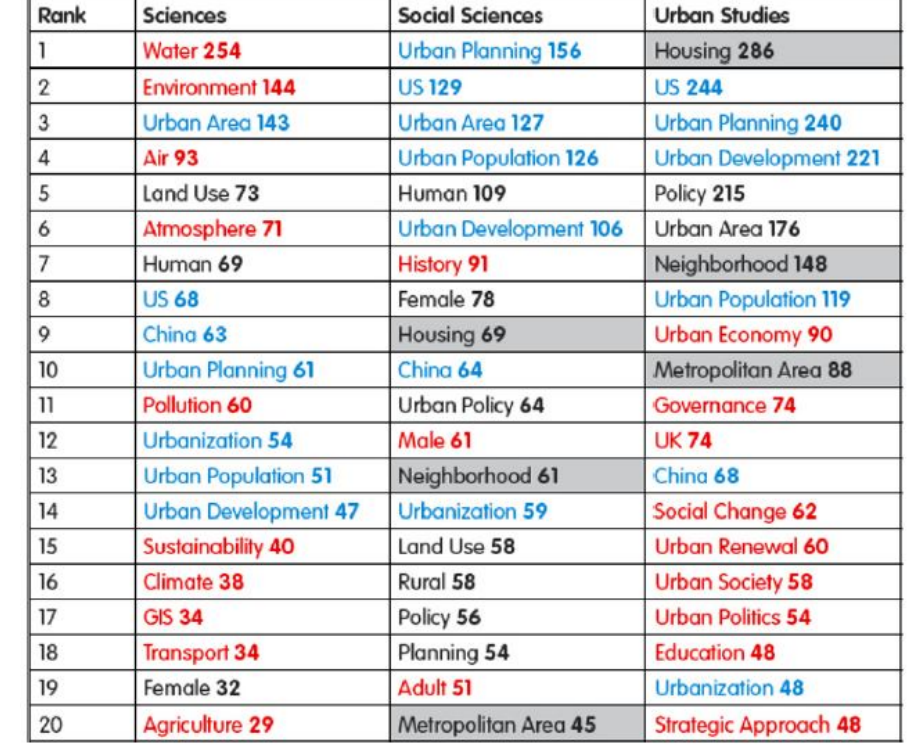
Figure 1. Frequency of key words, taken from Scopus, for journal articles in urban studies, the social sciences and the sciences: see Kamalski and Kirby for extended explanations. Red entries are unique to that column; blue are common to all